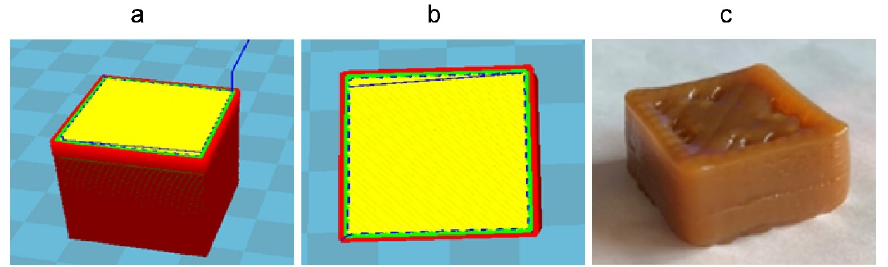
Figure 3. Three-dimensional printing of FKJ. ( a ) Scheme of the 3D printed cuboid, 2.5 × 2.5 × 1.25 cm 3 , designed in Cura15.02.1 software. ( b ) Transversal view of the 3D designed object. Cross-section of one layer showing the printhead pathway; the yellow part in the middle is the printing infill part, and the slash in the middle represents the infill patterns. ( c ) 3D printing of a cuboid with food-ink made of best formulation.